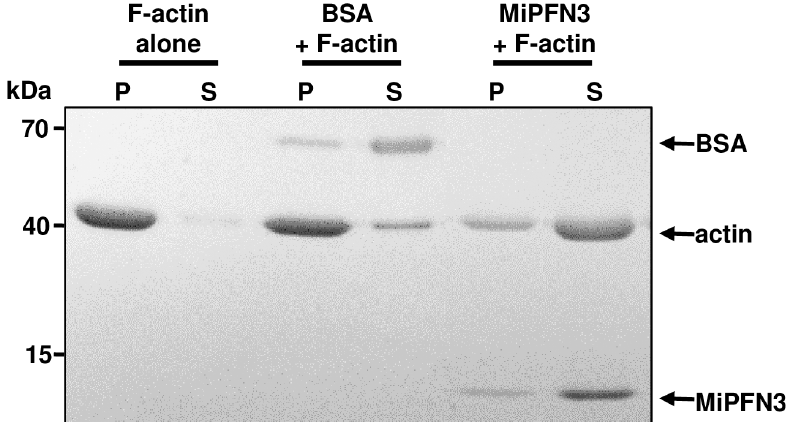
Fig 7. MiPFN3 affects actin polymerization in vitro . Non-muscular G actin (22μM) was incubated with BSA or 17 μM purified His-Mi131 for 30 minutes prior to actin polymerization. After actin polymerization, the samples were separated into the pellet (P) and supernatant (S) fractions by ultracentrifugation. The fractions were separated on a 4–20% SDS-PAGE and stained with Coomassie blue to visualize the proteins.